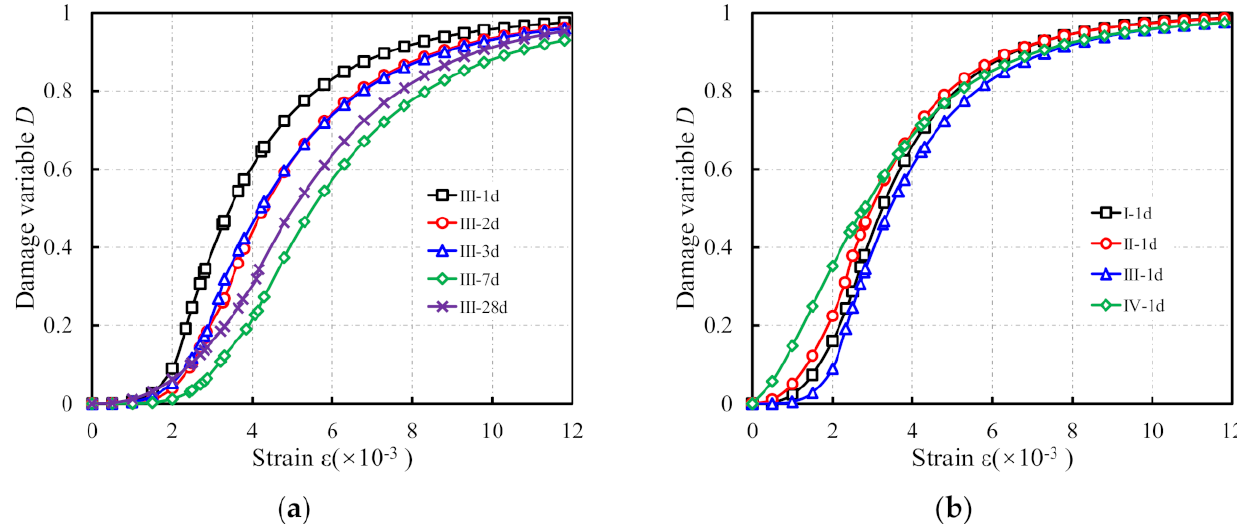
Figure 17. Variations of damage variable D of ( a ) CGM − 300 specimens; and ( b ) 1 d